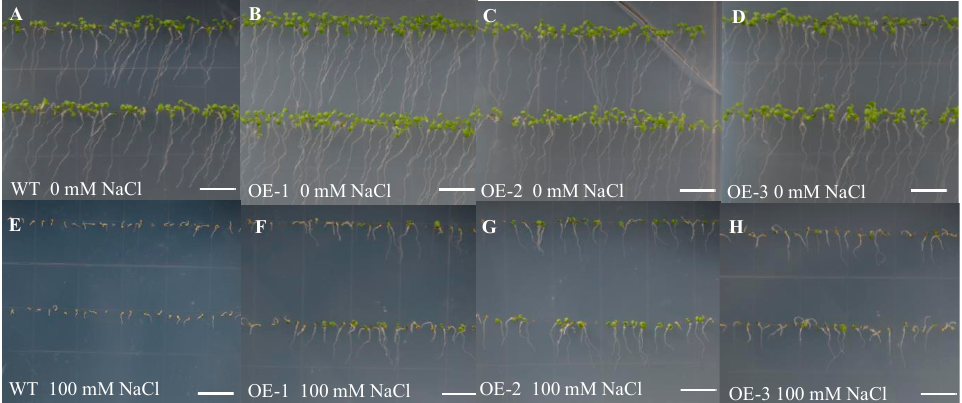
Figure 4. Under salt stress, LcMKK2-OE plants are healthier and develop longer roots. For the root length assay, seeds were sown in horizontal rows and plates incubated vertically. Top panels: A. thaliana wild-type ( A ) and three separate LcMKK2-OE lines ( B – D ) seedlings on low salt medium. Bottom panels: A. thaliana wild-type ( E ) and three separate LcMKK2-OE lines ( F – H ) seedlings on high salt medium. Scale bar = 1 cm.